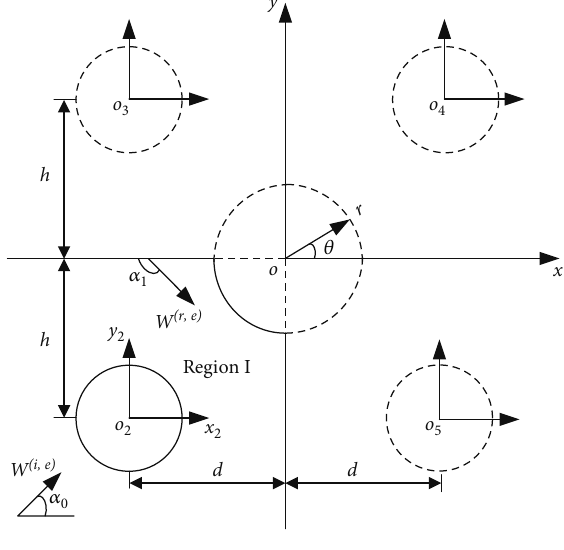
Figure 3: The mirror